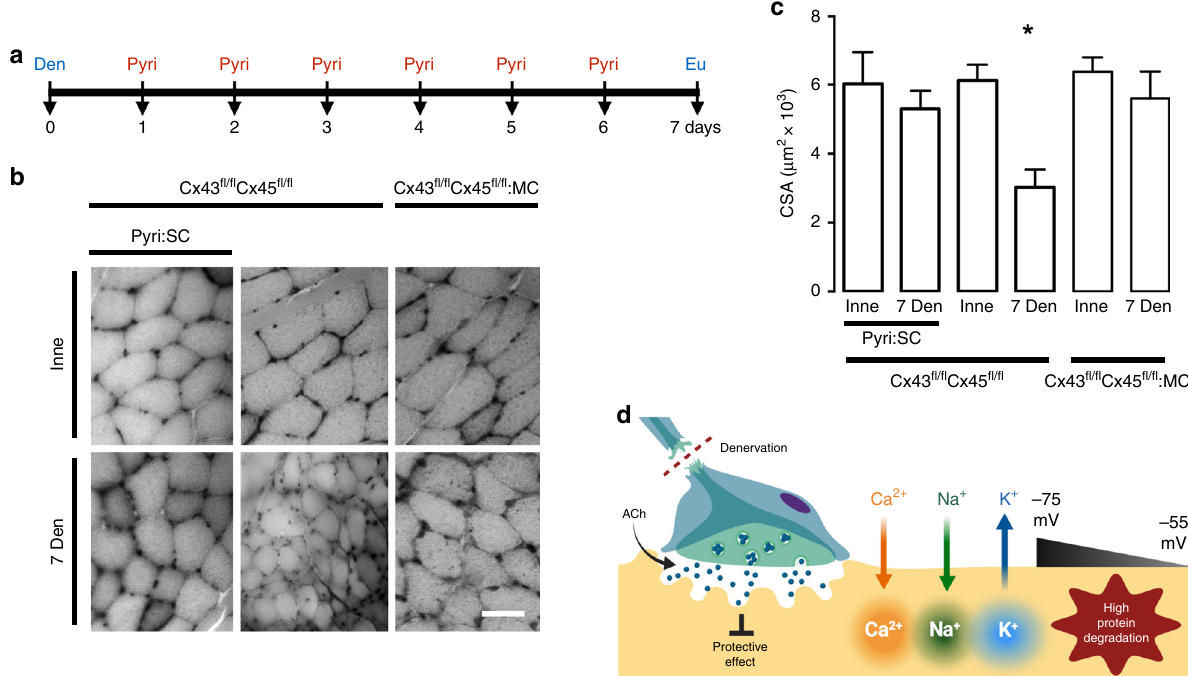
Fig. 3 Acetylcholine analog prevents cellular alterations in vitro, and increasing its half-life prevents the decrease of myo fi ber size in vivo. Unilateral denervation of the sciatic nerve in Cx43 fl / fl Cx45 fl / fl :Myo-Cre (Cx43 fl / fl Cx45 fl / fl :MC) mice were performed. a Experimental design of in vivo acetylcholinesterase blockade. Den: denervation, Pyiri: pyiridostigmine, Eu: euthanasia. b Hematoxylin:eosin-stained cross-section of the FDB at day 7 post denervation. Inne: Innervated. Den: Denervated. c Cross-sectional area (CSA). N = 5; each value is the mean ± SEM. * p < 0.05 for Den compared with Inne muscles by Student ’ s t test. d Proposed model. Denervation (Den) eliminates the protective effect of ACh and leads to a reduction in acetylcholine (ACh) release resulting in an increase in Ca 2 + and Na + in fl ux via de novo expressed non-selective membrane channels, increasing cytoplasmic concentrations of these ions. Consequently, a reduction in the RMP from − 75 to − 55 mV occurs due in part by K + ef fl ux and Ca 2 + and Na + in fl ux; the increase in intracellular Ca 2 + signal promotes protein